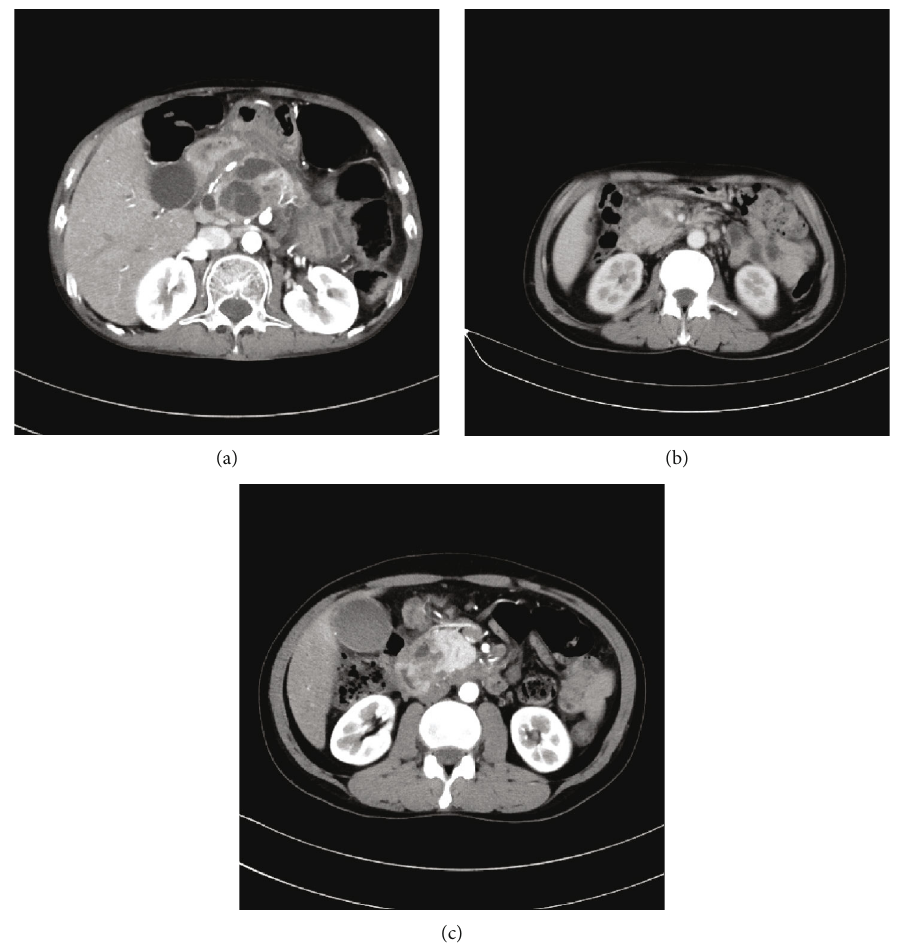
Figure 2: (a) IPMN of periampullary region. (b) Pancreatic adenocarcinoma of periampullary region. (c) Carcinoma of